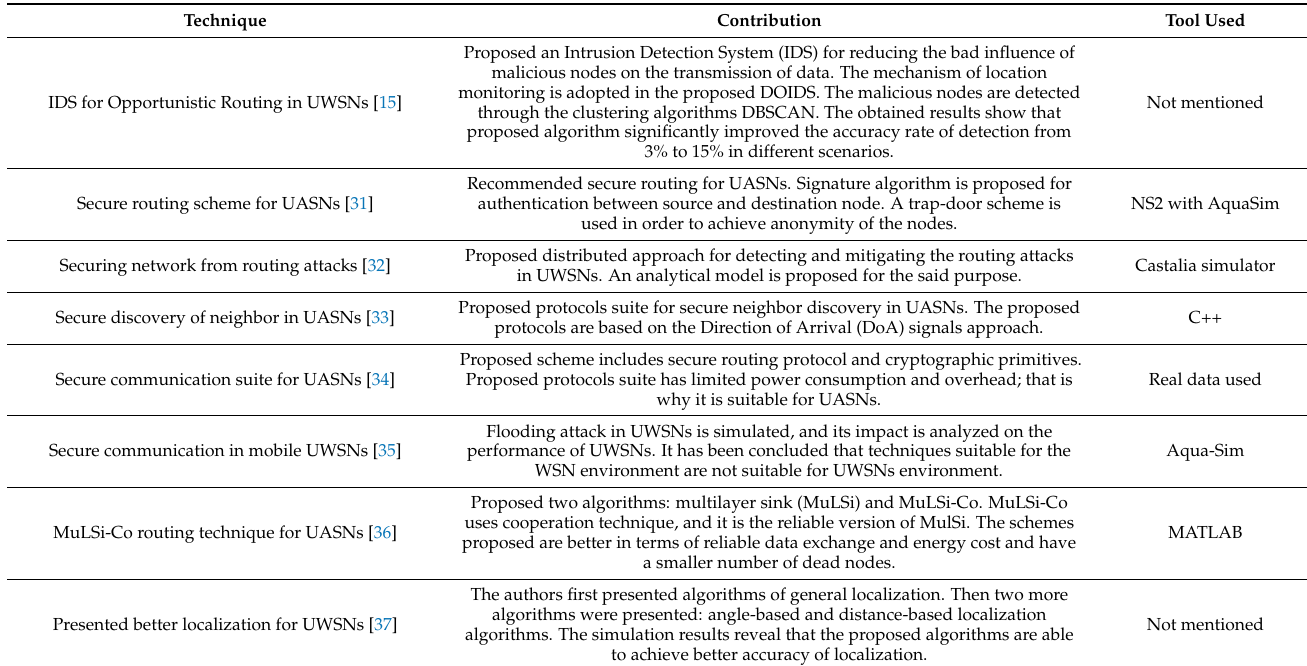
Table 1. Summary of related